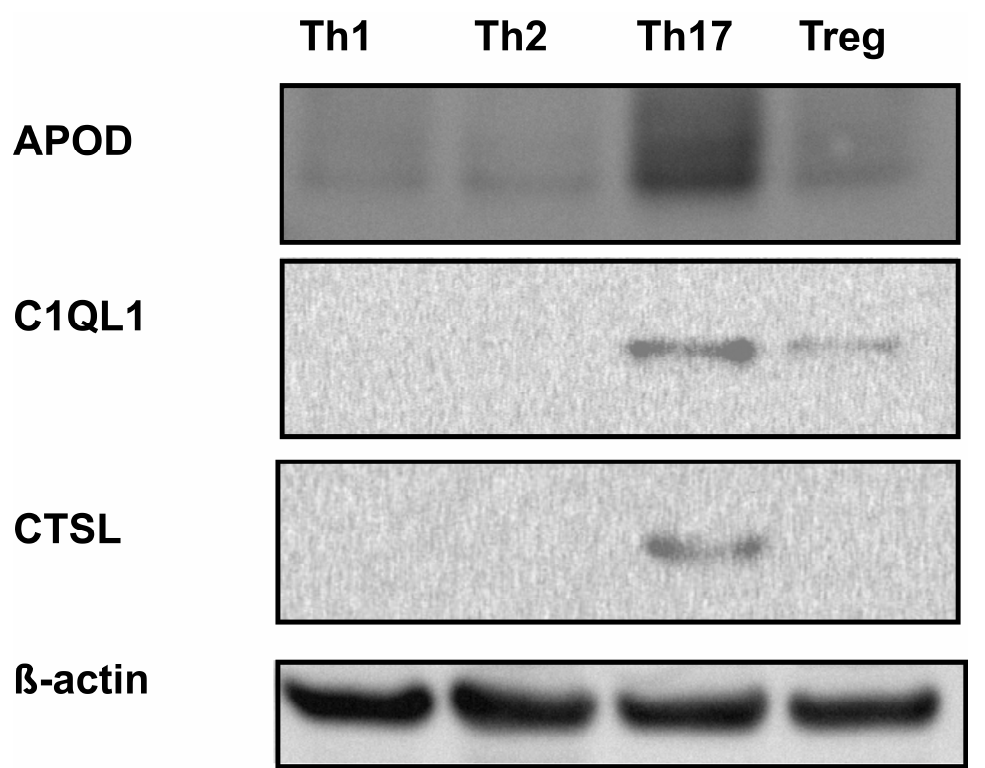
Figure 2. Representative Western blot detection of the APOD, C1QL1, and CTSL proteins in Th1, Th2, Th17 and Treg cells originating from CD4+ cells isolated from buffy coats. β-Actin was used as a loading control.